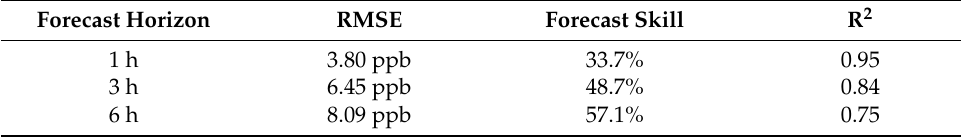
Table 1. Summary of results for ozone prediction using GraphSAGE model.